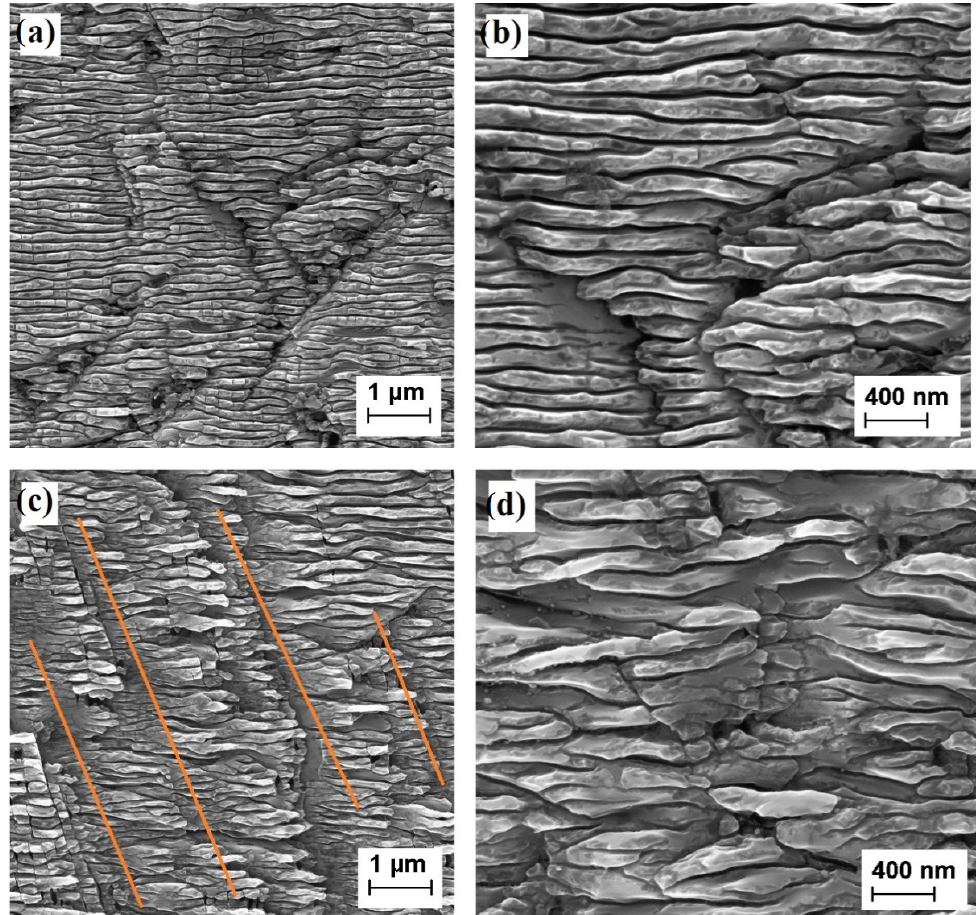
Figure 2. Top view of the central area of samples 2T-9010 (panels ( a , b )) and 2T-8020 (panels ( c , d